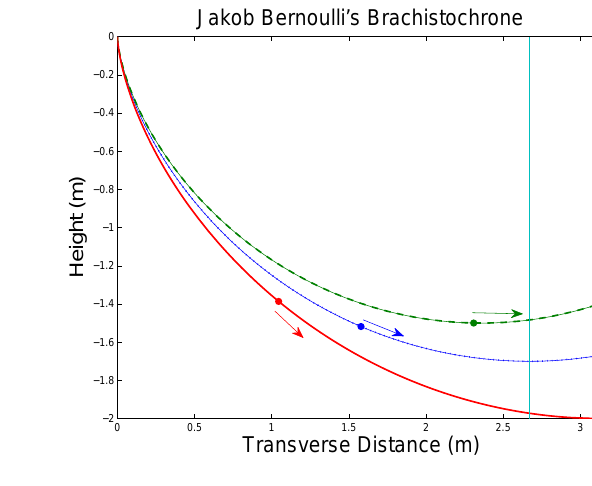
Figure 6: John Bernoulli’s Brachistochrone. Figure 7: Jakob Bernoulli’s